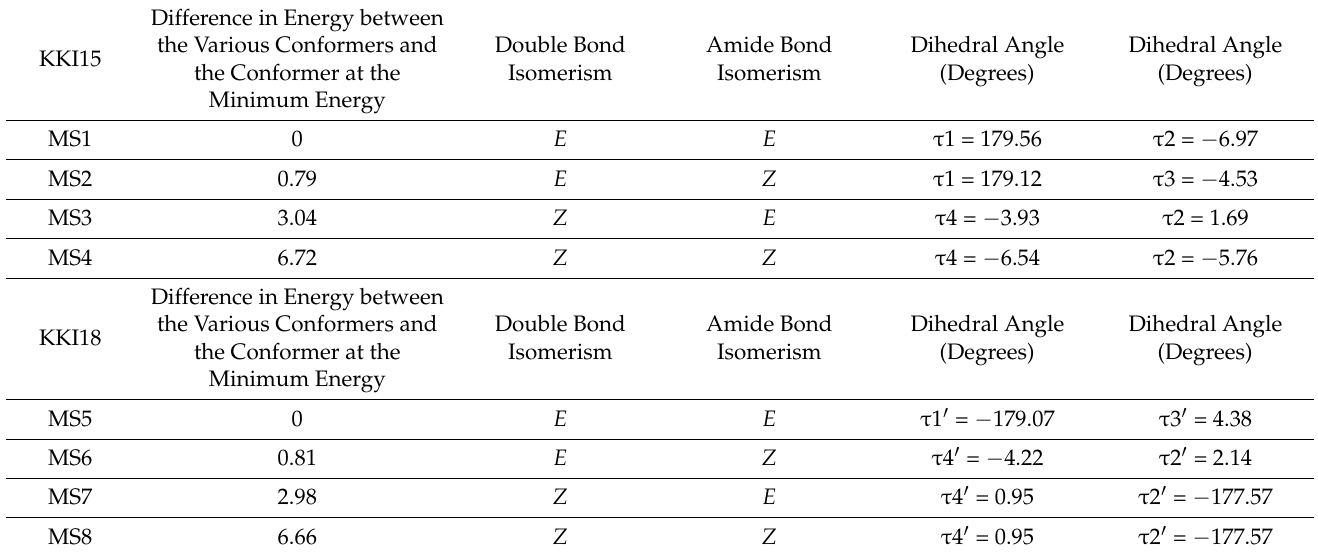
Table 2. Results of energy minimization calculations. The values are given in Hartree, while their difference from the stable structure MS1 for KKI15 and MS5 for KKI18 in kcal/mol (top). Values in degrees of the dihedral angles, of the minimized structures (MS) for KKI15 and KKI18 (bottom).